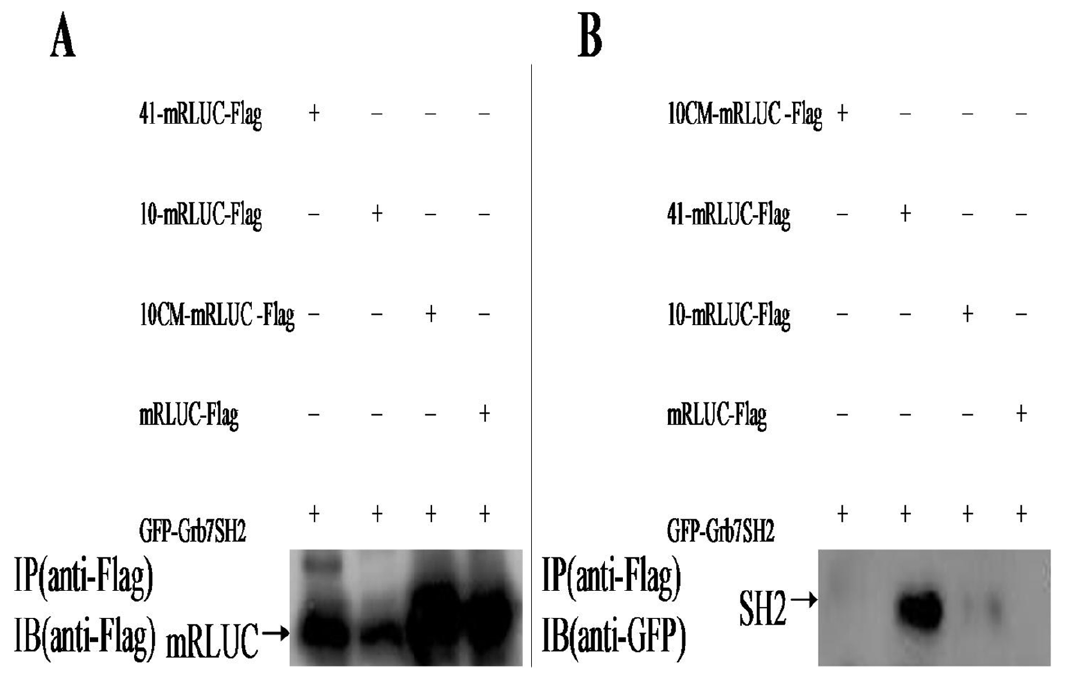
Figure 1. The nonphosphorylated peptide 41 and the Grb7 SH2 domain are co-immunoprecipitated from transfected HEK293T cells. A ) Expression of nonphosphorylated peptides. B ) Interactions between nonphosphorylated peptides and the Grb7 SH2 domain.